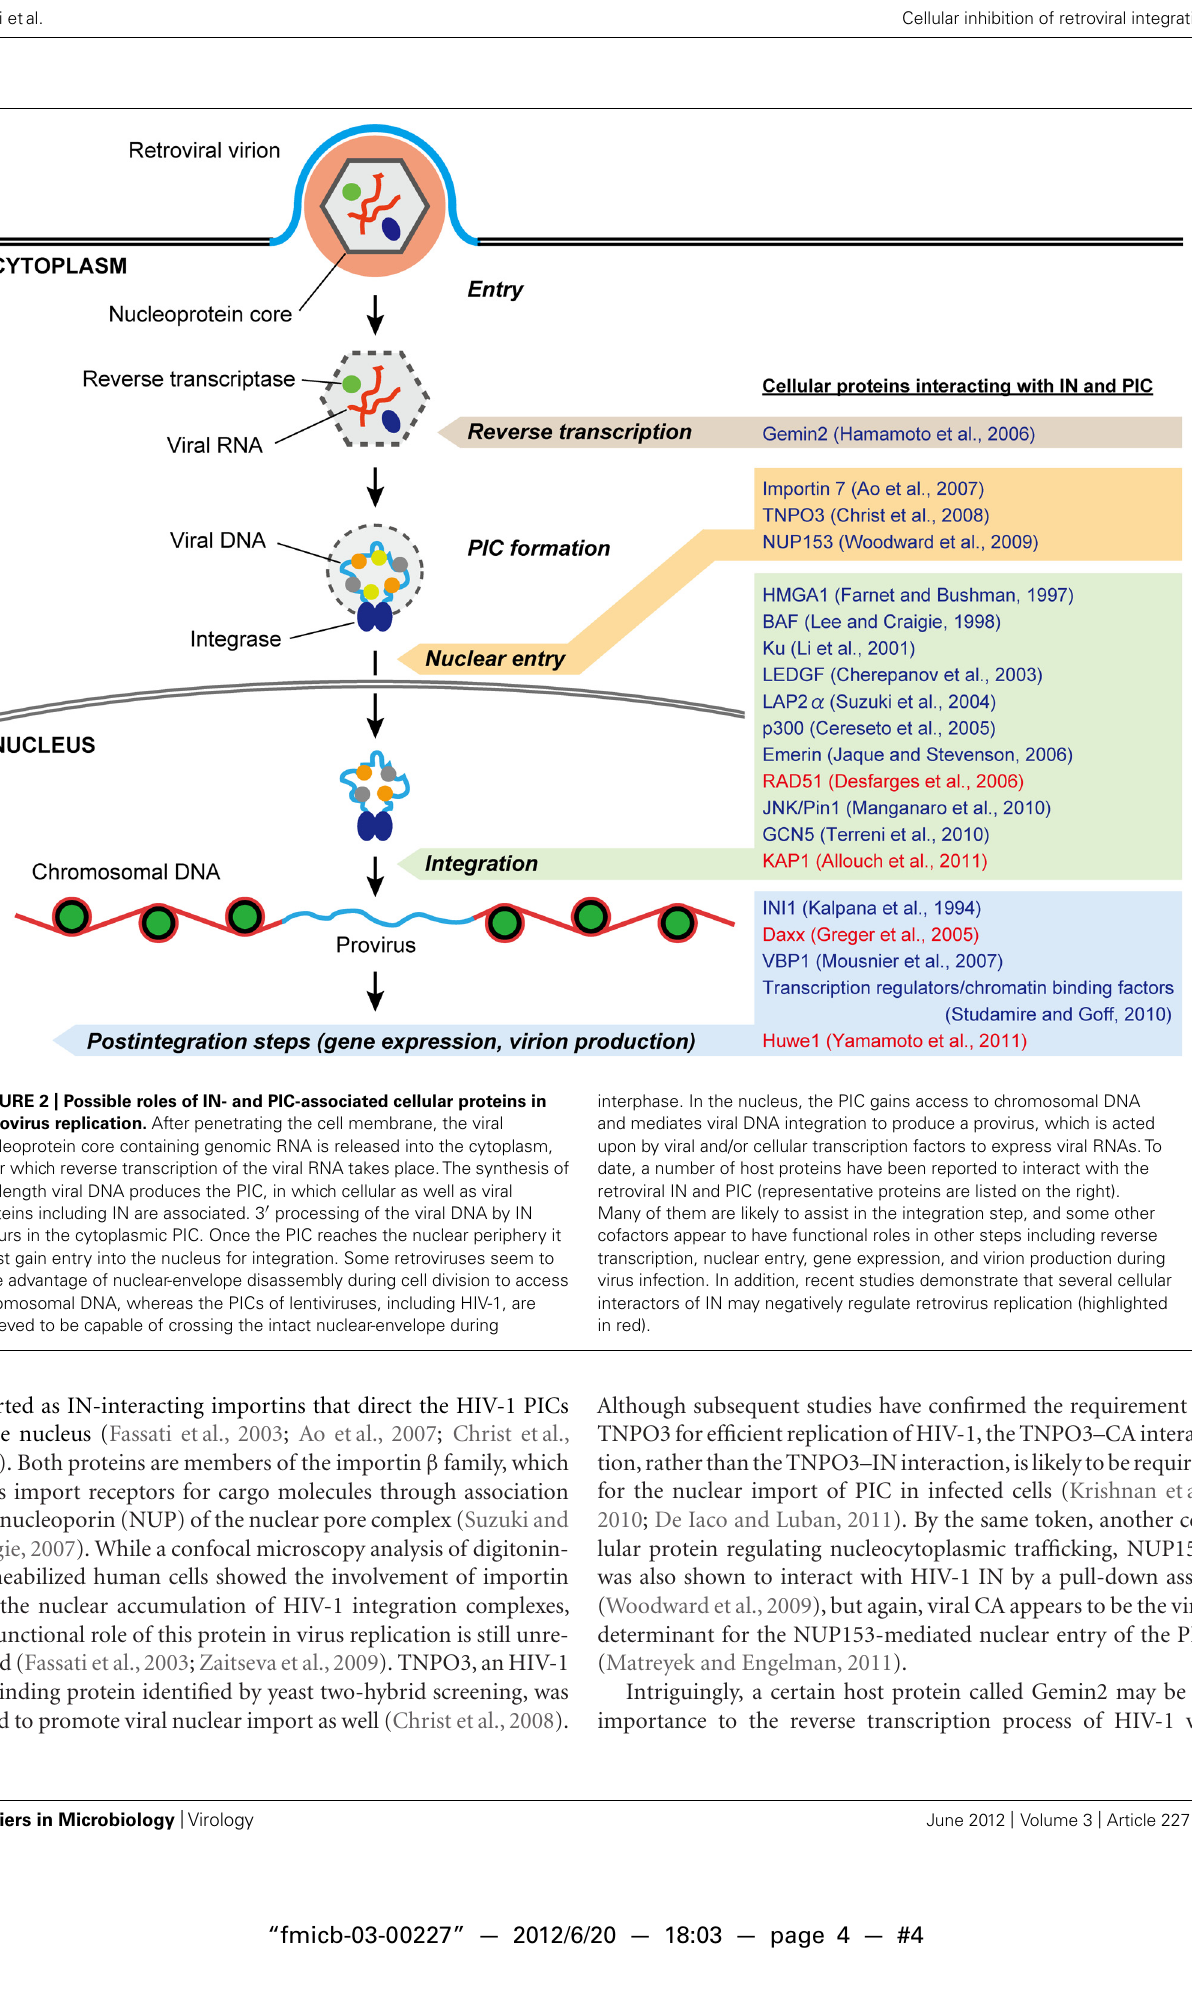
FIGURE 2 | Possible roles of IN- and PIC-associated cellular proteins in retrovirus replication. After penetrating the cell membrane, the viral nucleoprotein core containing genomic RNA is released into the cytoplasm, after which reverse transcription of the viral RNA takes place.The synthesis of full-length viral DNA produces the PIC, in which cellular as well as viral proteins including IN are associated. 3 (cid:2) processing of the viral DNA by IN occurs in the cytoplasmic PIC. Once the PIC reaches the nuclear periphery it must gain entry into the nucleus for integration. Some retroviruses seem to take advantage of nuclear-envelope disassembly during cell division to access chromosomal DNA, whereas the PICs of lentiviruses, including HIV-1, are believed to be capable of crossing the intact nuclear-envelope during